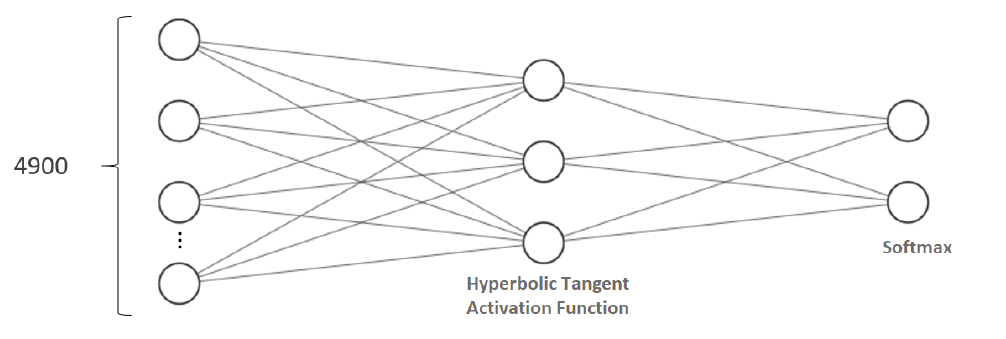
Figure 2. The proposed SNN model.